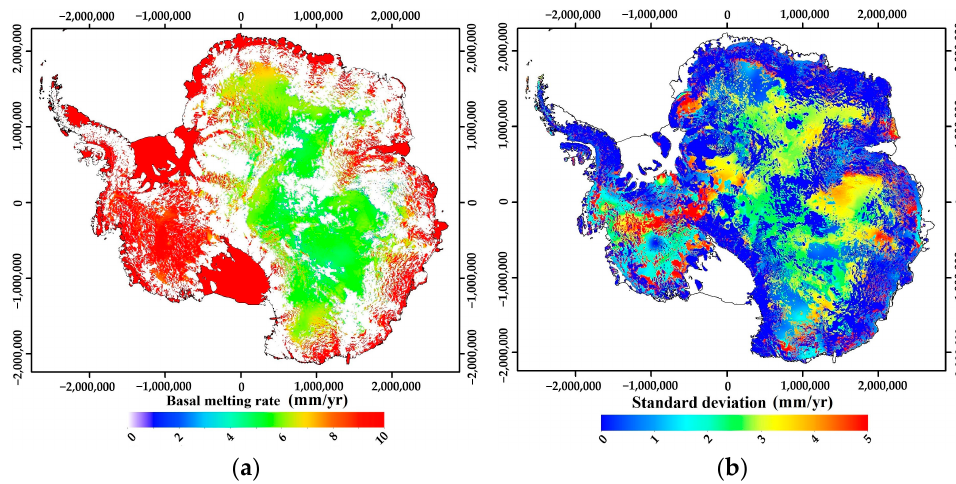
Figure 7. ( a ) Basal melting rates over AIS (truncated at 10 mm/y) and ( b ) associated standard deviation. This dataset is available from Pattyn [11].